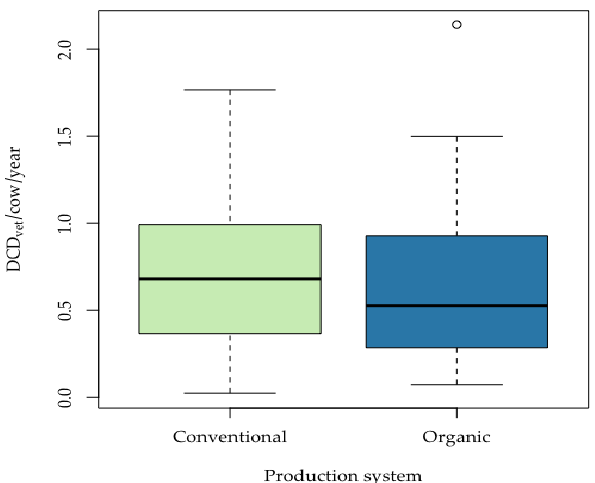
Figure 4. Defined Course Doses for aDCT on conventional and organic dairy farms (aDCT = antimicrobial dry cow therapy, DCD vet = Defined Course Dose) Box = range between Q1 and Q3; horizontal line = median; lower whisker = Q1−1.5 (IQR) (interquartile range); upper whisker = Q3 + 1.5(IQR); circles = outliers.